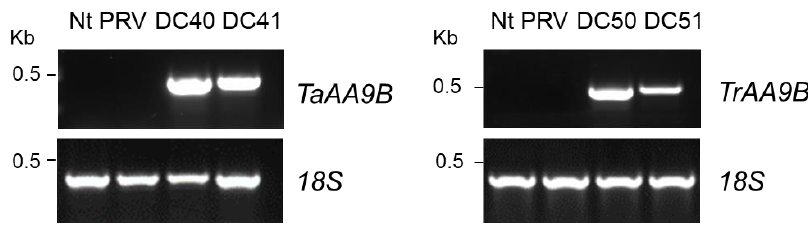
Figure 4. Representative examples of semi-quantitative RT-PCR (27 cycles) analysis of selected T2 transplastomic plants to verify the expression of TaAA9B and TrAA9B transgenes. DC40 and DC41 transplastomic plants expressing AA9 LPMO from Thermoascus aurantiacus (TaAA9B); DC50 and DC51 transplastomic plants expressing AA9 LPMO from Trichoderma reesei (TrAA9B); Nt and PRV control plants, wild type and transformed with the empty vector, respectively.